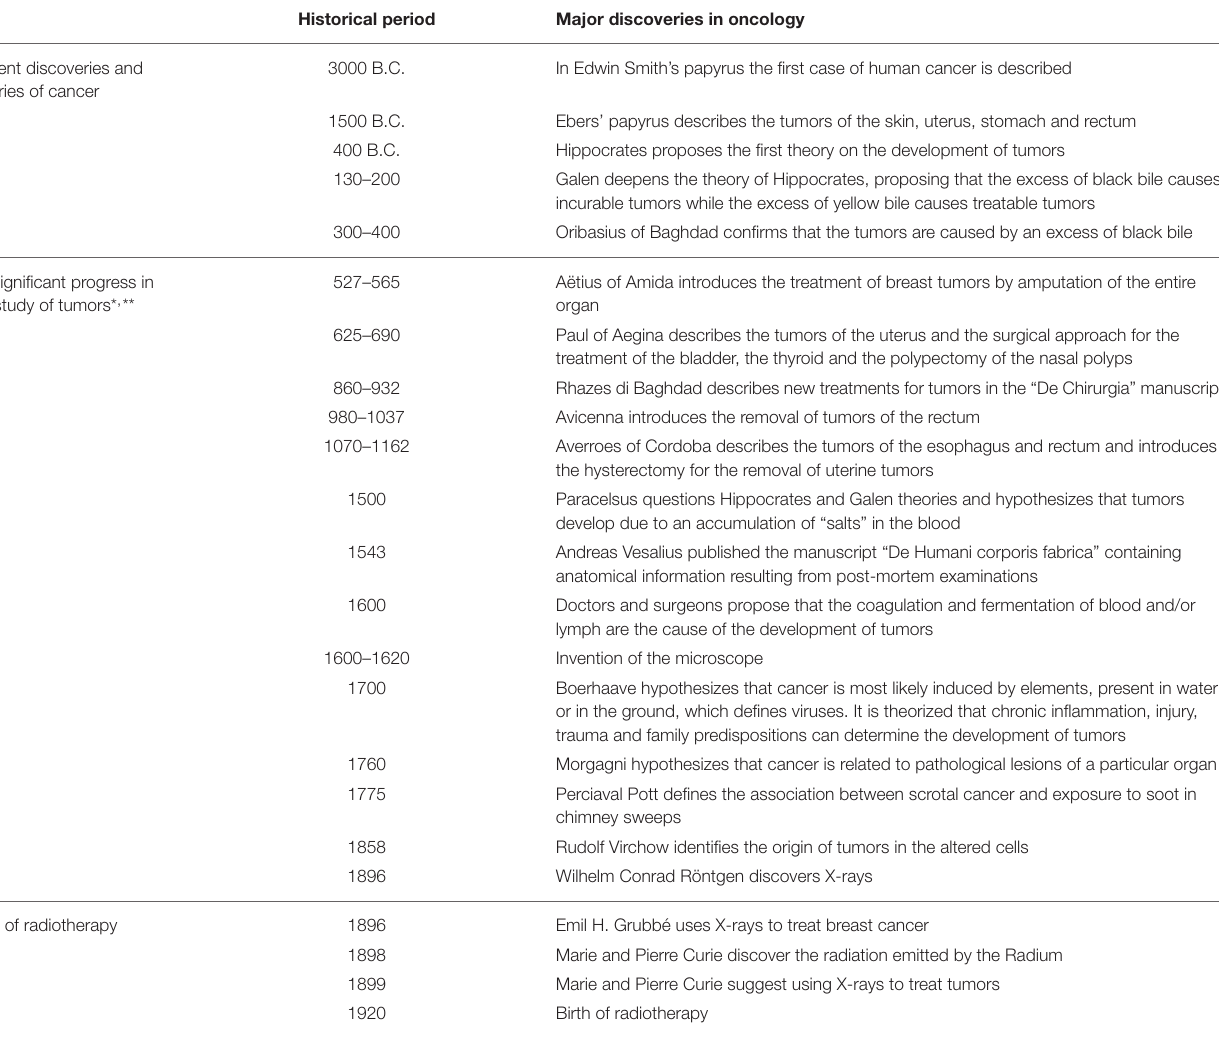
TABLE 1 | Milestones of oncology research before